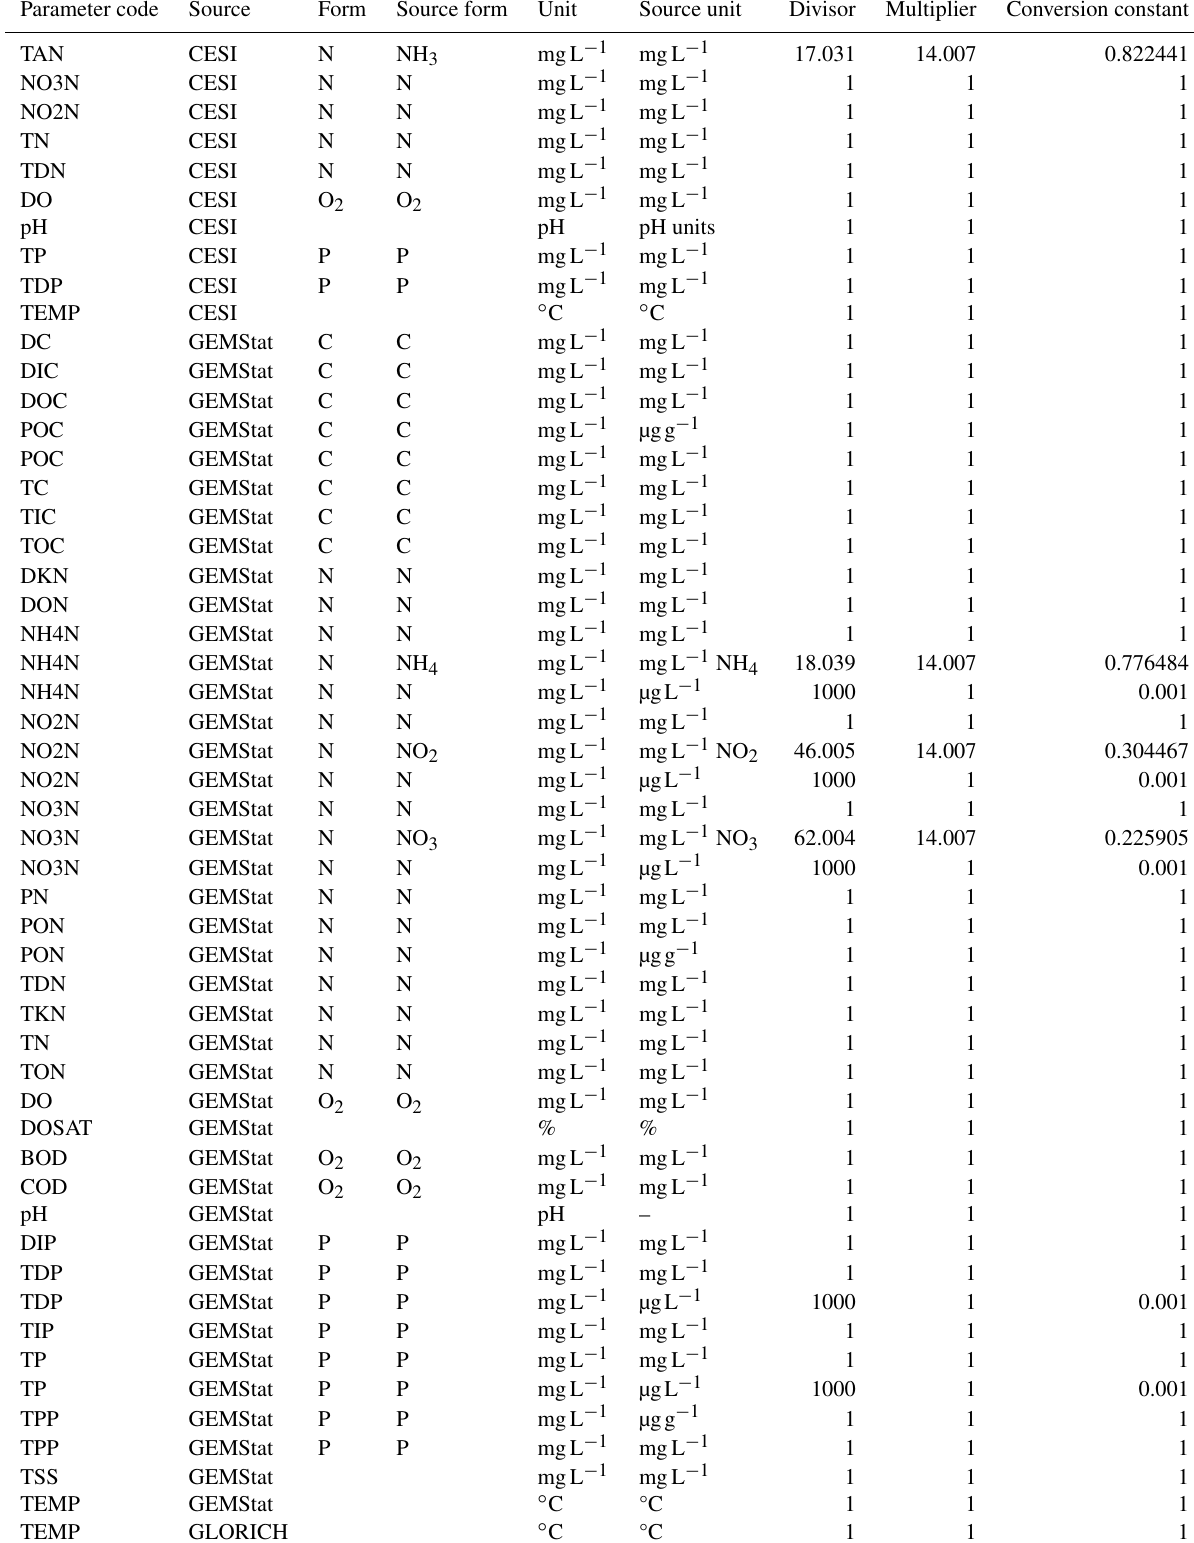
Table A1. Conversion procedures of source data units and chemical forms into their corresponding GRQA versions for all parameters. Parameter